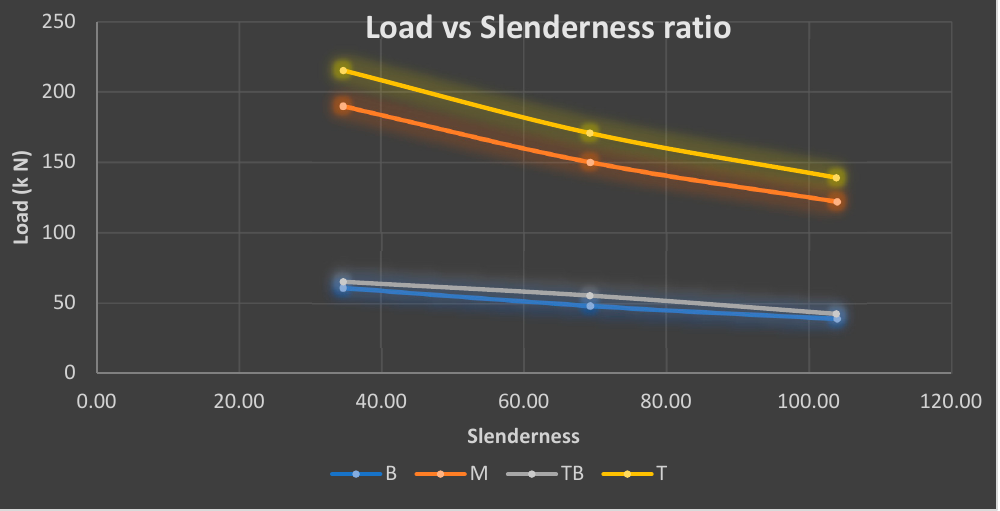
Figure 15. Comparison of capacity load of TDGLC + TG.